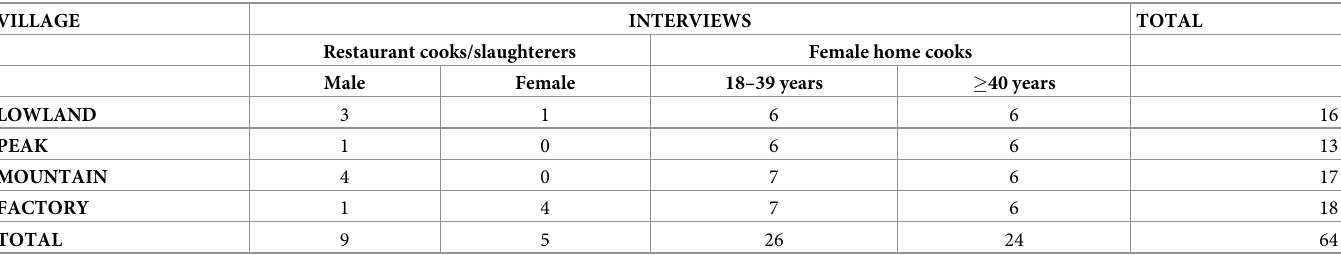
Table 2. Overview of number of